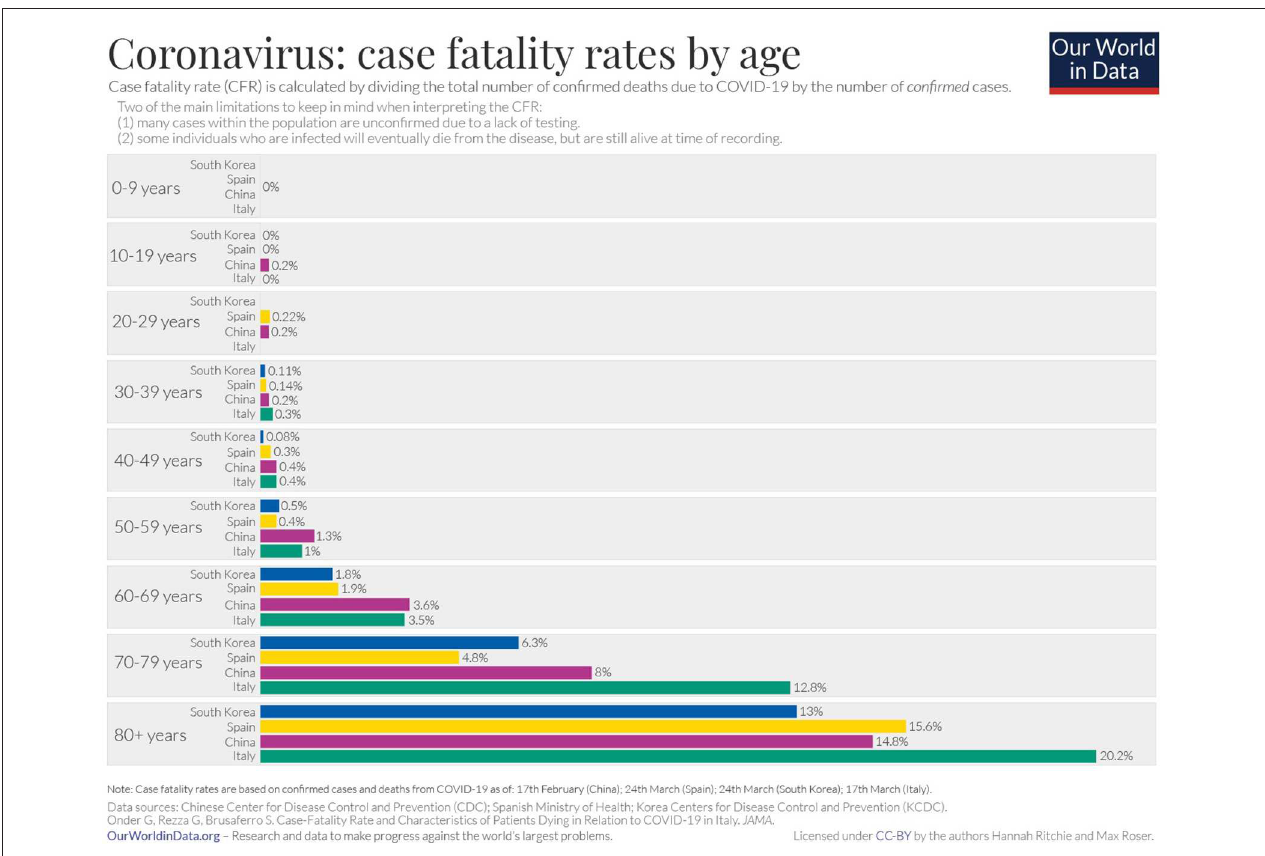
FIGURE 3 | Case fatality rate by age in selected countries as of April 2020